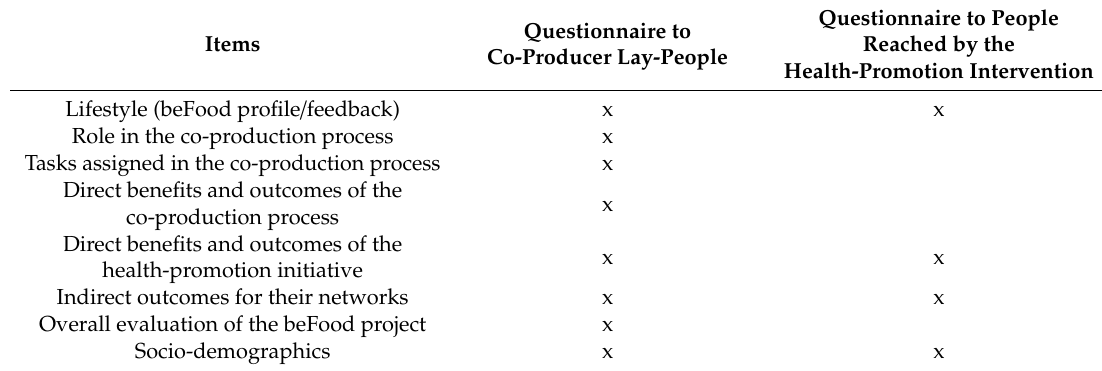
Table 2. Topics investigated by the two questionnaires: (i) to lay-people involved into the co-production processes of beFood and (ii) to people reached by the health promotion intervention itself. Questionnaire to People Questionnaire to Reached by the Items Co-Producer Lay-People Health-Promotion Intervention Lifestyle (beFood profile / feedback) x x Role in the co-production process x Tasks assigned in the co-production process x Direct benefits and outcomes of the x co-production process Direct benefits and outcomes of the x x health-promotion initiative Indirect outcomes for their